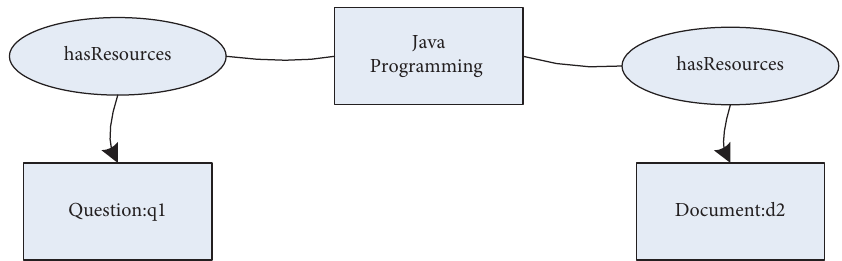
Figure 4: Integration of the question and document within social relationship graph.